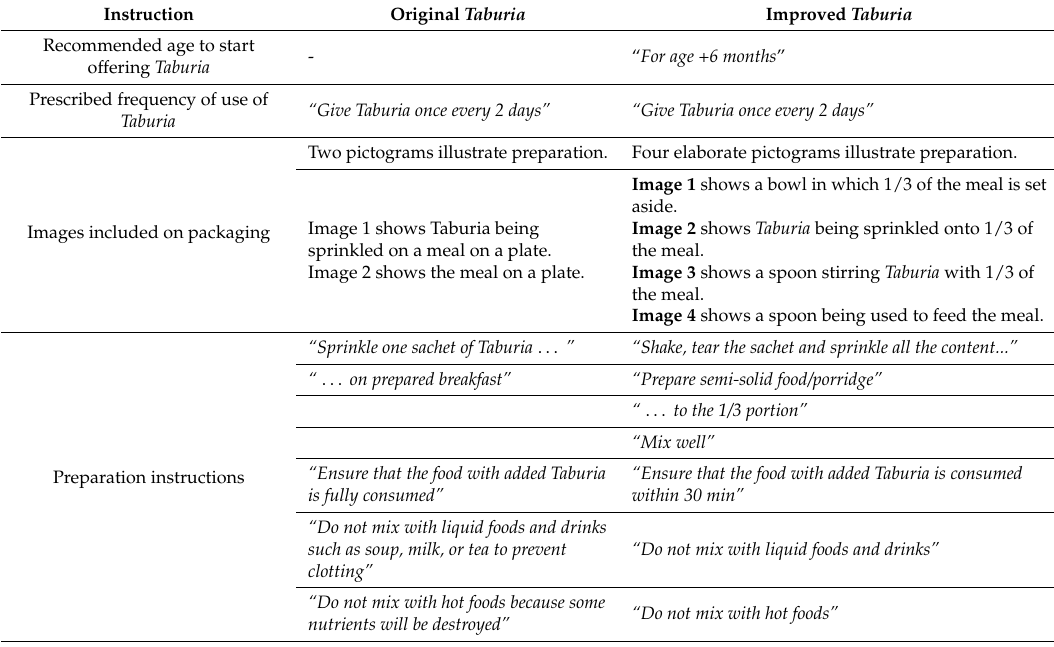
Table 1. Directions for use of Taburia in the original and improved Taburia packaging information on outer